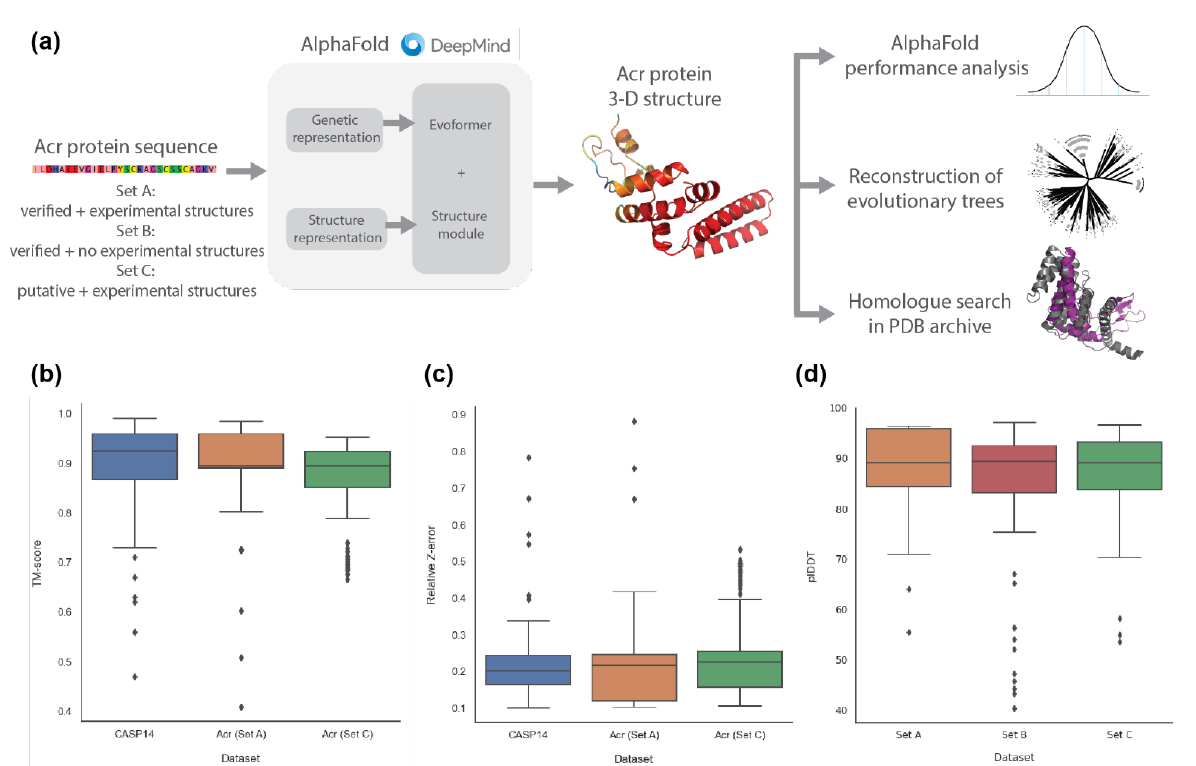
Figure 2. Performance analysis of AlphaFold2 on anti-CRISPR proteins in comparison to the CASP14 dataset. ( a ) Overall workflow to analyse the 3-D macromolecular structures of Acr protein sequences predicted with AlphaFold2. ( b ) The performance of AlphaFold2 on the Acr protein datasets in comparison to the CASP14 dataset using TM-scores. The closer the TM-score is to 1, the more similar the predicted structure is to its true experimental structure. ( c ) The performance of AlphaFold2 on the Acr protein datasets in comparison to the CASP14 dataset using relative Z-errors. The closer the relative Z-error is to 0, the more similar the predicted structure is to its true experimental structure. ( d ) The performance of AlphaFold2 on the Acr protein datasets using plDDT. The closer the plDDT is to 100, the higher the confidence level of prediction by AlphaFold2. (Set A: Verified Acr proteins with experimental structures, Set B: Verified Acr proteins without experimental structures, Set C: Putative Acr proteins with experimental